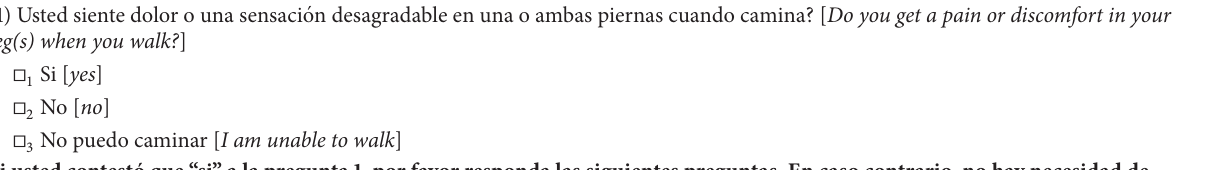
Table 1: Culturally adapted Spanish translation of the Edinburgh claudication questionnaire [ with original English version ] used in Atahualpa residents.